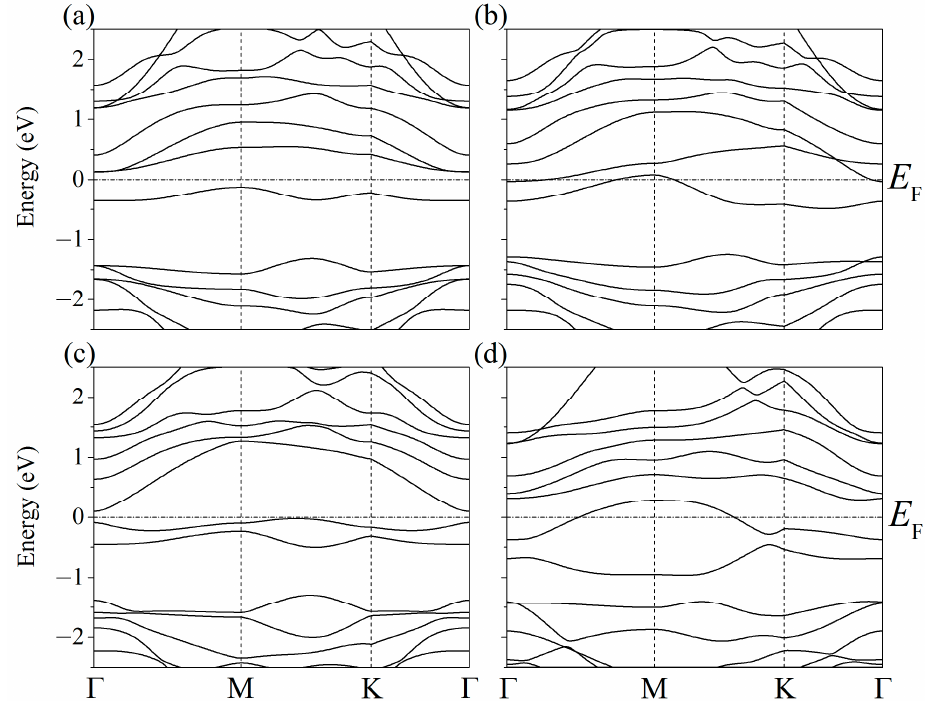
Figure 9. Band structures of silicene modified with one ( a , b ) or two ( c , d ) phosphorus atoms upon adsorption of one lithium atom in a position above the center of the six-membered ring; ( a , b ) P atom is in the lower or upper sublattice of silicene, respectively ( c ) two P atoms are in the lower sublattice or two P atoms are in the upper sublattice; ( d ) one P atom is in the upper sublattice, and the other P atom is in the bottom one.